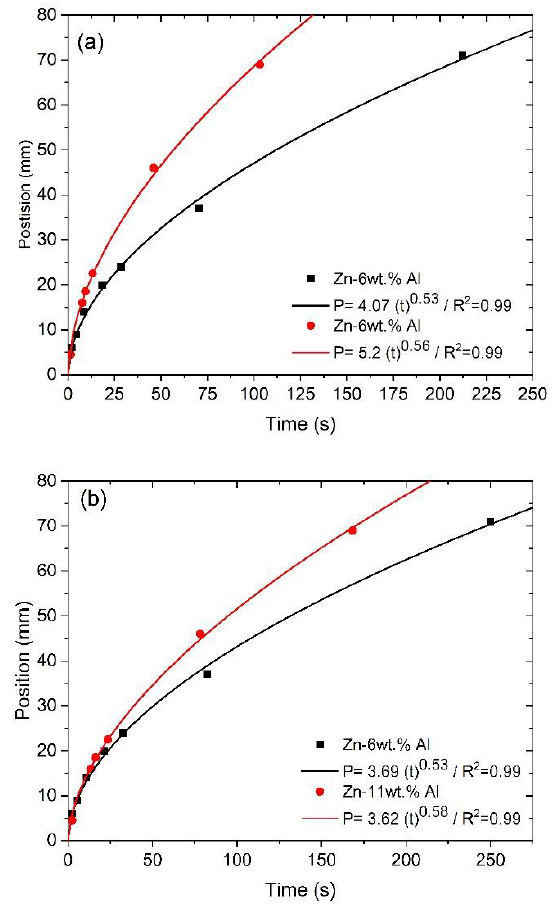
Figure 5. Experimental displacement of liquidus and eutectic isotherms along the length of the DS alloys castings, where: P (mm) is the thermocouple position from the cooled bottom of the casting and t (s) is time: ( a ) liquidus isotherm and ( b ) eutectic isotherm. R 2 is the coefficient of determination. The cooling rate profiles related to the liquidus, and the eutectic isotherms are shown in Figure 6. A power function of the form Ṫ = cP − d , being c and d constants, is fitted to the experimental points along the length of each alloy casting. The cooling rate profiles of both Zn-6wt.%Al and Zn-11wt.%Al alloys castings show that at positions close to the cooled bottom of the castings the solidification process occurs at high cooling rates.